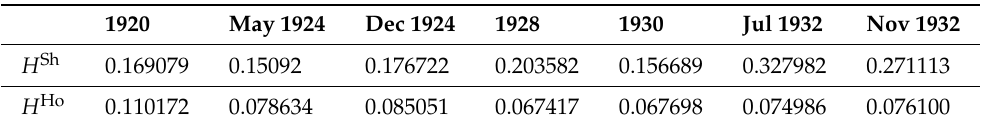
Table 2. Results for Weimar Republic parliament in 1918–1932,